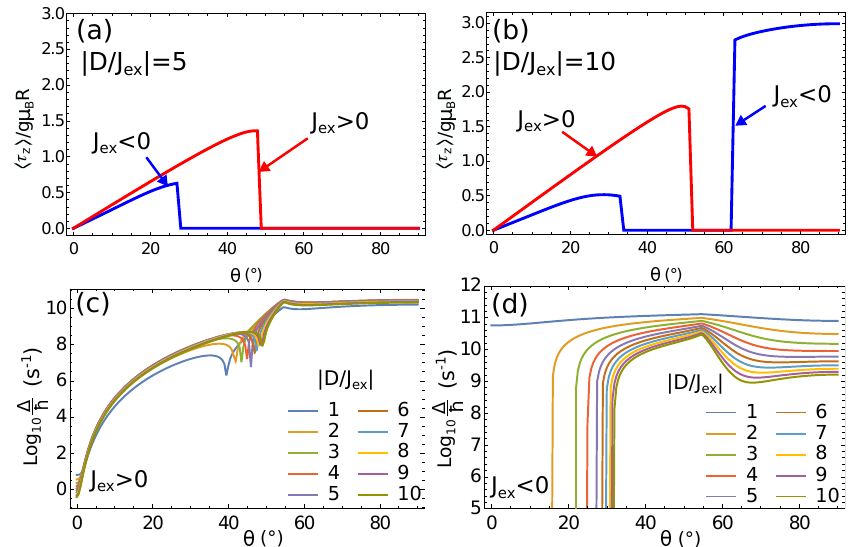
Figure 3. ( a , b ) Toroidal moment expectation value computed on the quasi -degenerate ground man- ifold of the triangle with ferromagnetic (red) and antiferromagnetic (blue) Heisenberg exchange coupling for ( a ) | D / J ex | = 5 and ( b ) | D / J ex | = 10. ( c , d ) Tunnelling rate of the ground-state toroidal moment as a function of canting angle θ in the molecular triangle with on-site spin S = 1 for a range of magnetic anisotropy strengths | D / J ex | and ( c ) ferromagnetic and ( d ) antiferromagnetic exchange